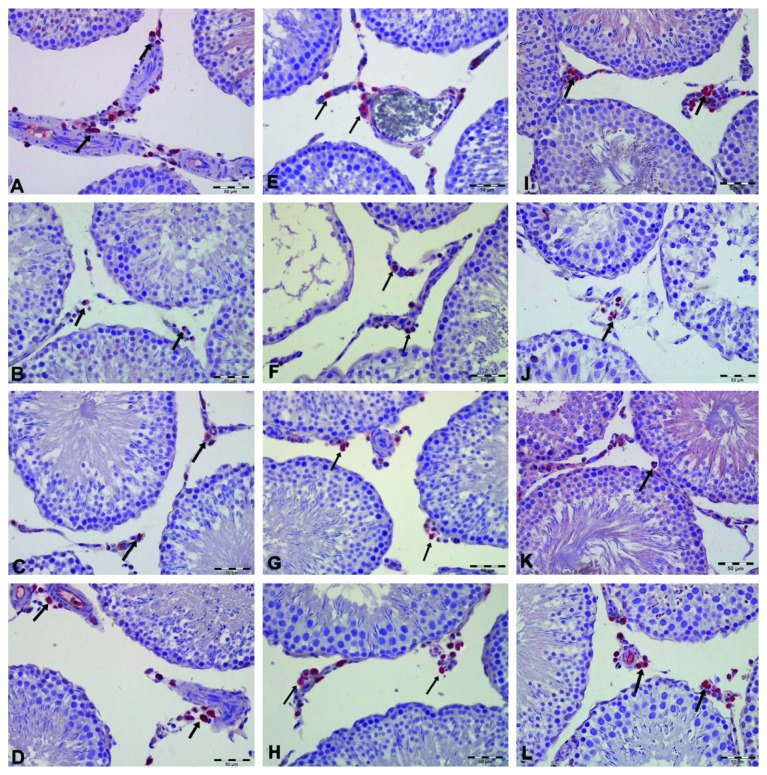
3βHSD, INSL3, and GPRC6A immunoreactivity in testicular tissue samples of EDS-administered subjects (Group 2). (a) High 3βHSD expression was reported in Leydig cells of control subjects (Group 2A). (b) 3βHSD expression decreased in Leydig cells of GnRH-antagonist-administered subjects (Group 2B). (c) A decrease in 3βHSD expression was seen to continue in Leydig cells of GnRH-antagonist-and-osteocalcin-administered subjects (Group 2C). (d) Intensive 3βHSD expression was observed in Leydig cells of only-osteocalcin-administered subjects (Group 2D). (e) High INSL3 expression was detected in Leydig cells of control subjects (Group 2A). (f) INSL3 expression decreased in Leydig cells of GnRH-antagonist-administered subjects (Group 2B). (g) A decrease in INSL3 expression was reported to continue in Leydig cells of GnRH-antagonist-and-osteocalcin-administered subjects (Group 2C). (h) High INSL3 expression was observed in Leydig cells of only-osteocalcin-administered subjects (Group 2D). (i) High INSL3 expression was seen in Leydig cells of control subjects (Group 2A). (j) GPRC6A expression decreased in Leydig cells of GnRH-antagonist-administered subjects (Group 2B). (k) A decrease in GPRC6A expression was seen to continue in Leydig cells of GnRH-antagonist-and-osteocalcin-administered subjects (Group 2C). (l) High GPRC6A expression was observed in only-osteocalcin-administered subjects (Group 2D). Bar = 50 μm.